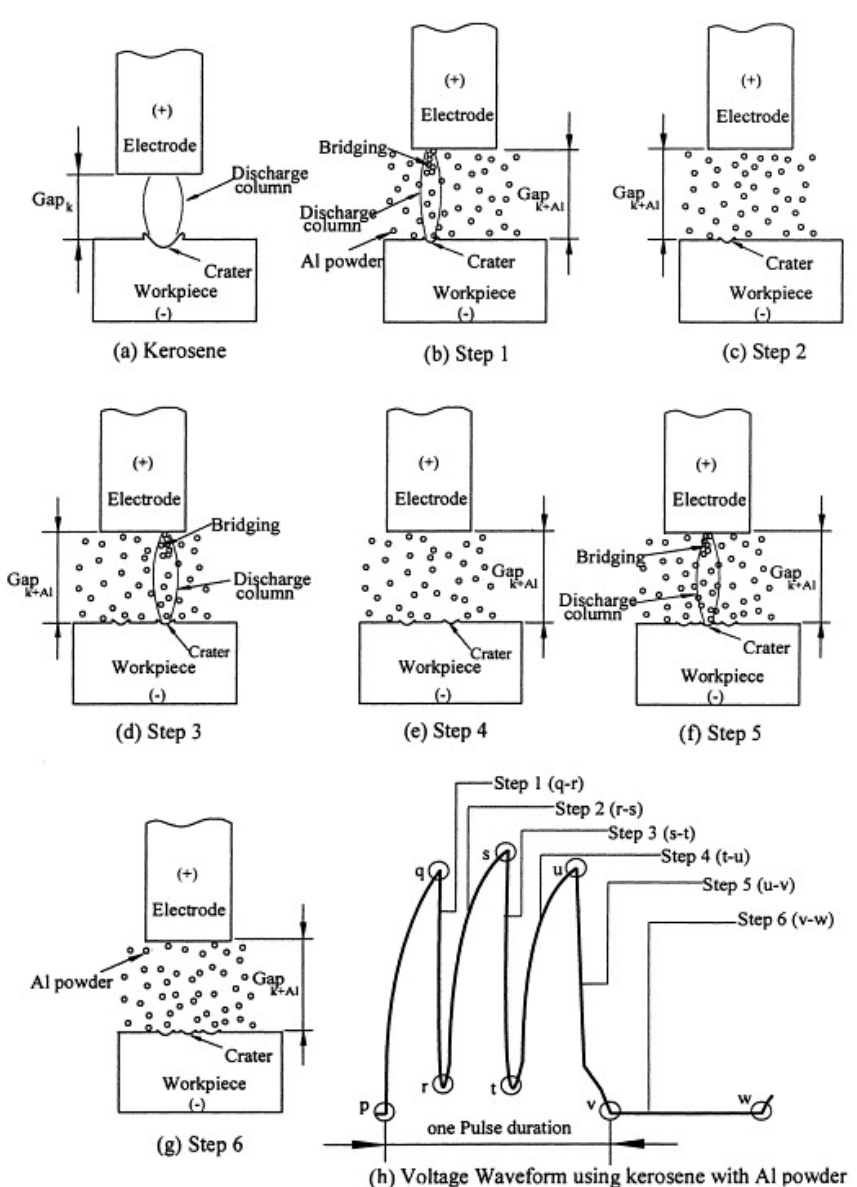
Figure 3. Influence of Al powder additive in kerosene dielectric medium during the machining process [22].